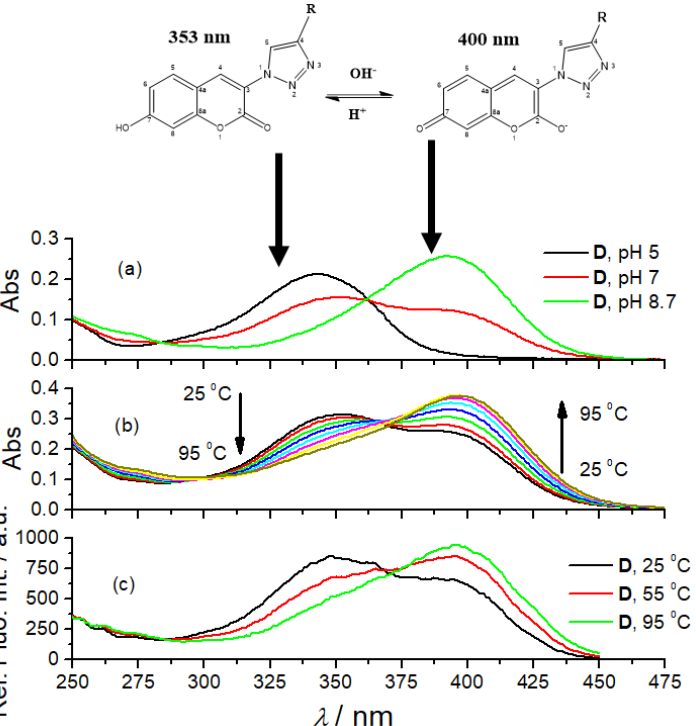
Figure 1. The dependence of amino acid coumarin D UV/Vis spectra ( c = 2 × 10 − 5 M) on pH ( a ); temperature ( b ); and pH dependence ( c ) of D fluorescence excitation spectra ( c = 1 × 10 − 6 M, λ em = 475 nm).